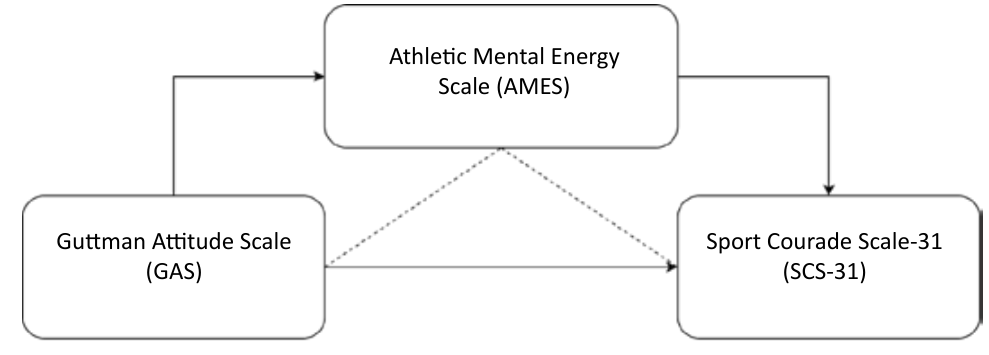
Figure 1. Sobel Test